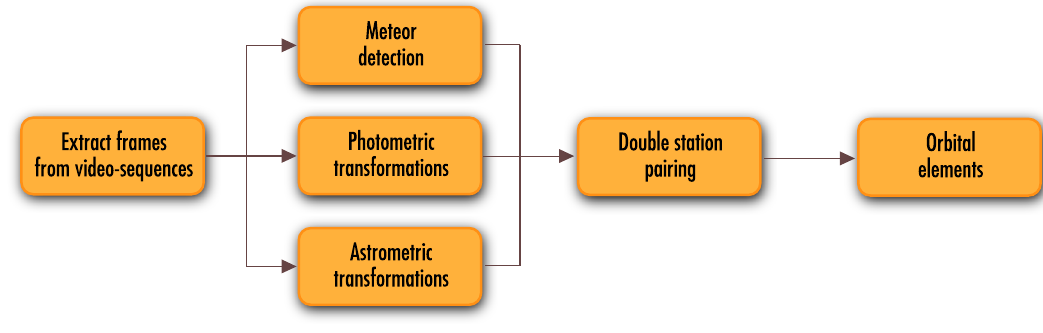
Figure 6. Double-station video processing pipeline.